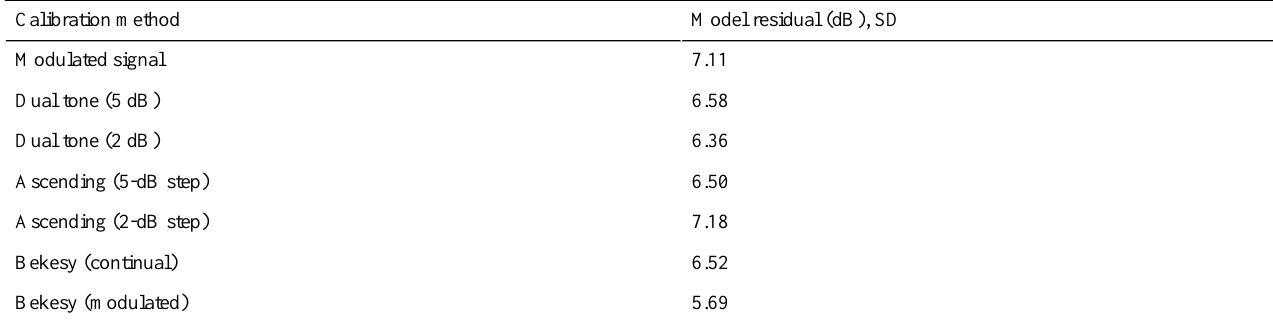
Table 2. Standard deviation of residual of the model based on A-weight filter estimated by means of measurements at 8 frequencies carried out by 25 participants.